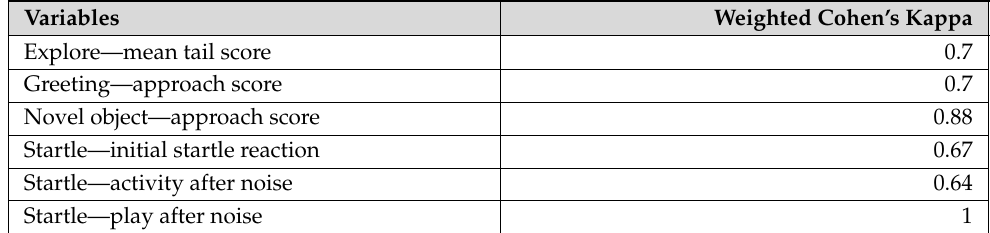
Table 6. Inter-rater reliability for